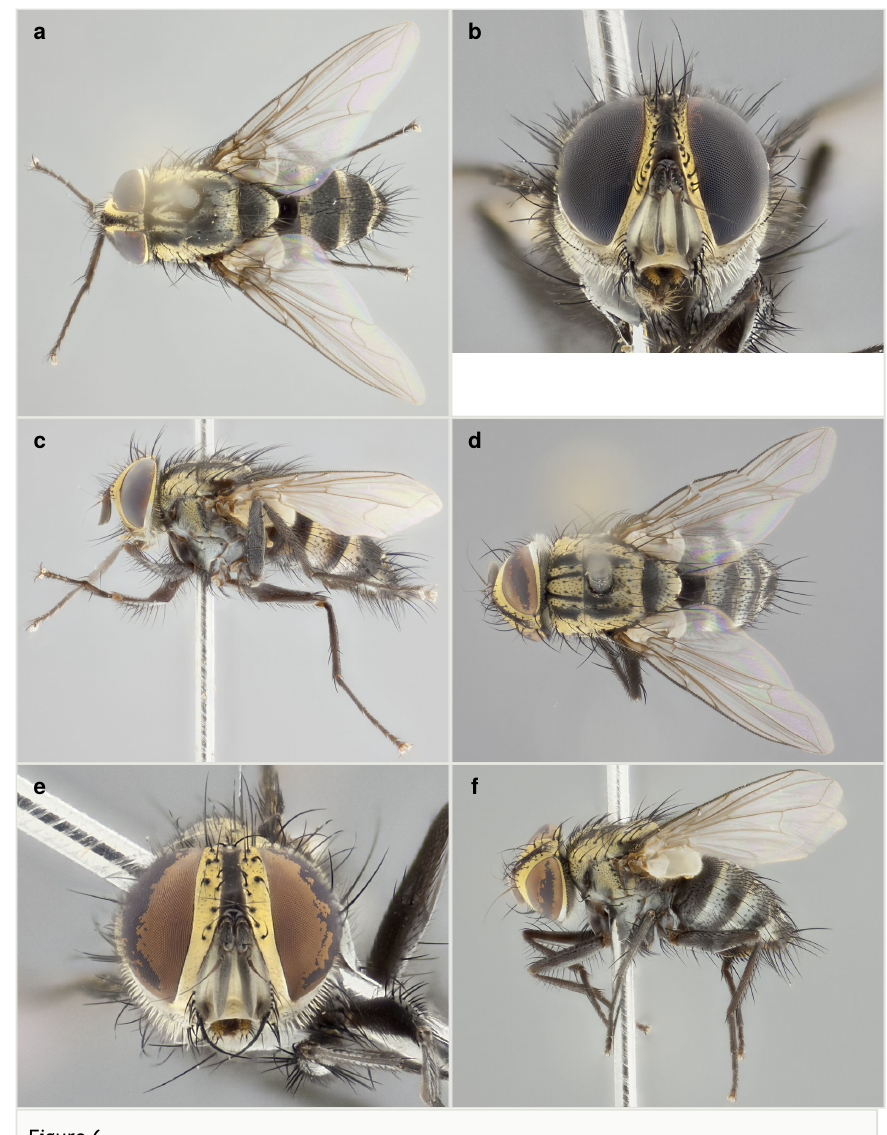
Vibrissina randycurtisi sp. n. a–c : holotype male, voucher code: DHJPAR0007167; d–f : paratype female, voucher code: